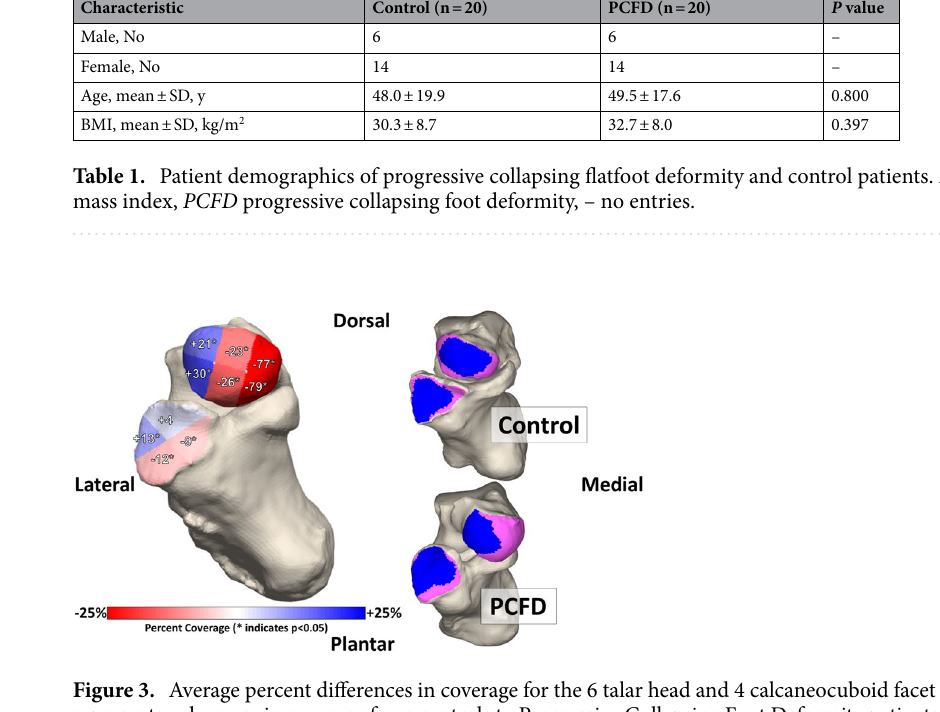
Figure 3. Average percent differences in coverage for the 6 talar head and 4 calcaneocuboid facet regions. Red represents a decrease in coverage from controls to Progressive Collapsing Foot Deformity patients while blue represents an increase.